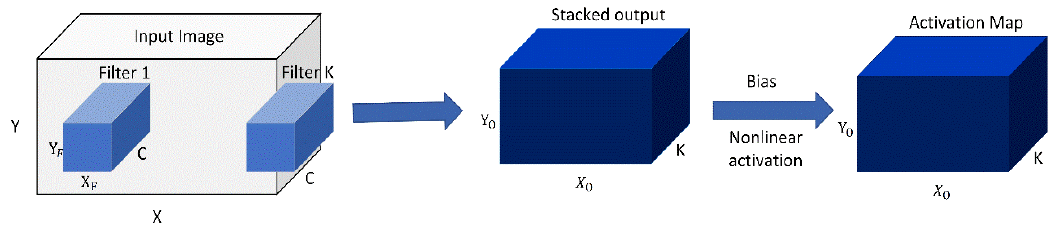
Fig. 5 Illustration of convolution layer